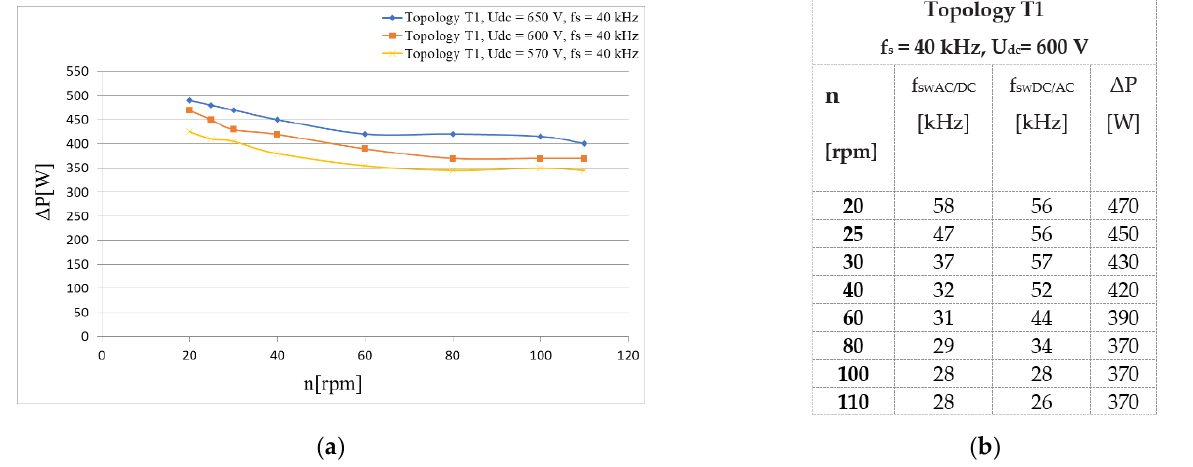
Figure 10. ( a ) Power losses in the converter system of the topology T1 at different voltages in the DC circuit and ( b ) switching frequency f sw of the transistors in both converters at U dc = 600 V.